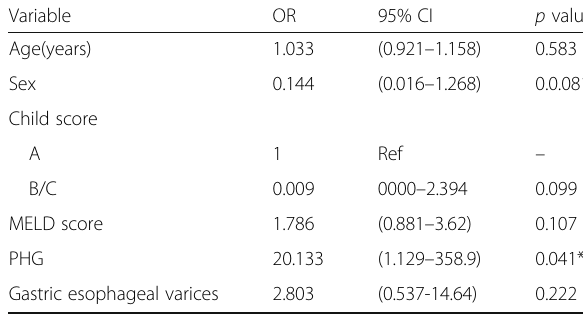
Table 4 Multiple logistic regression analysis of